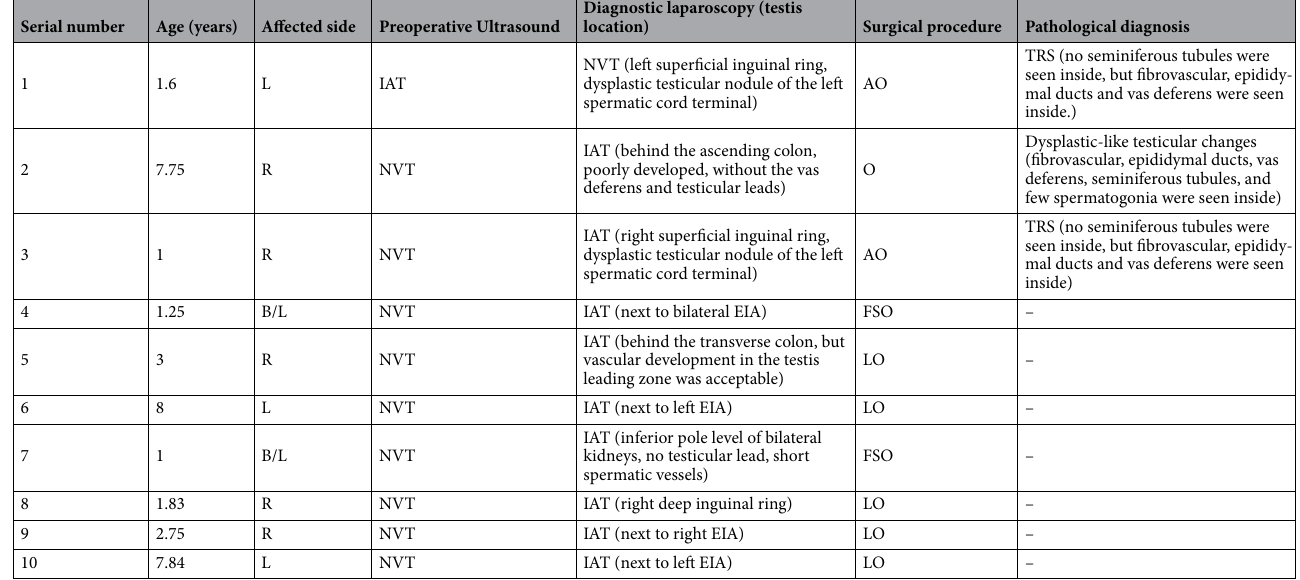
Table 2. Age, clinical manifestations and management of NPT cases misdiagnosed by preoperative ultrasound (10 cases in total, 12 testes). L left, R right, B/L bilateral, IAT intra-abdominal testis, EAT extra-abdominal